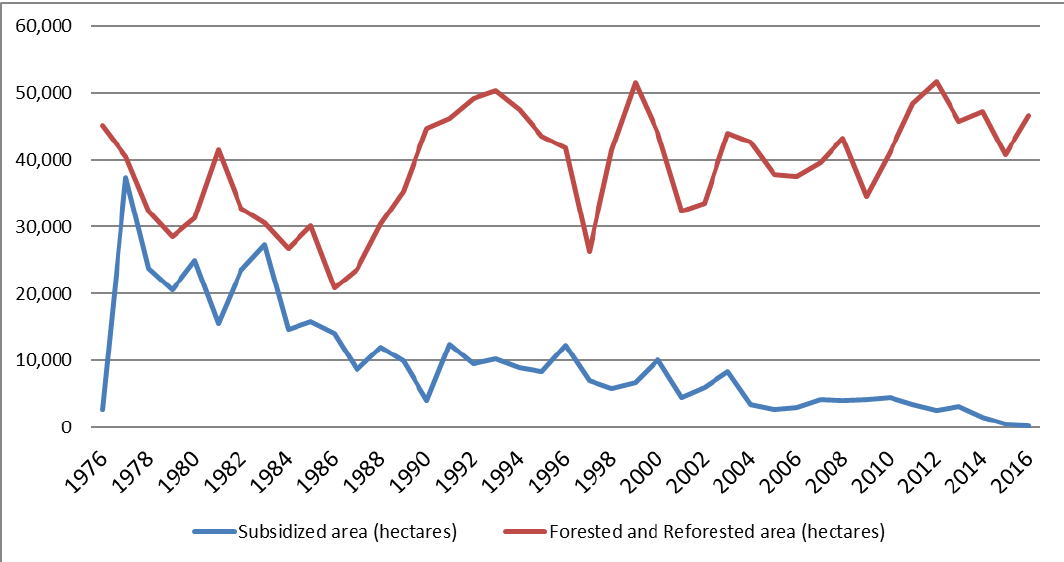
Figure 3. Subsidized, afforested, and reforested area in the study area .